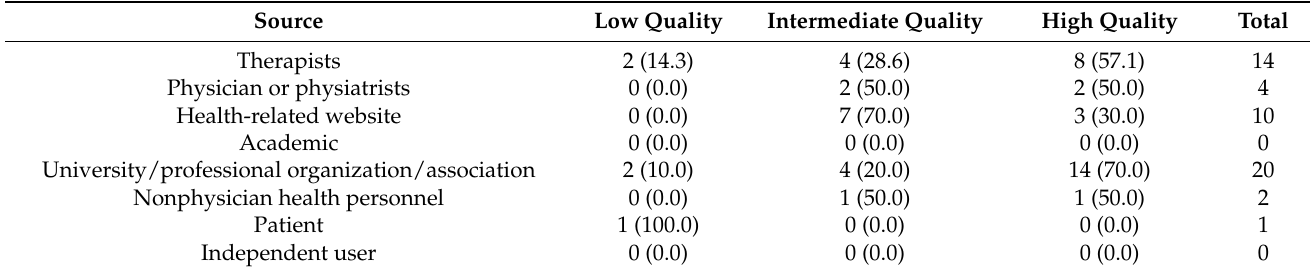
Table 3. Categorization of the videos according to sources, n (%).